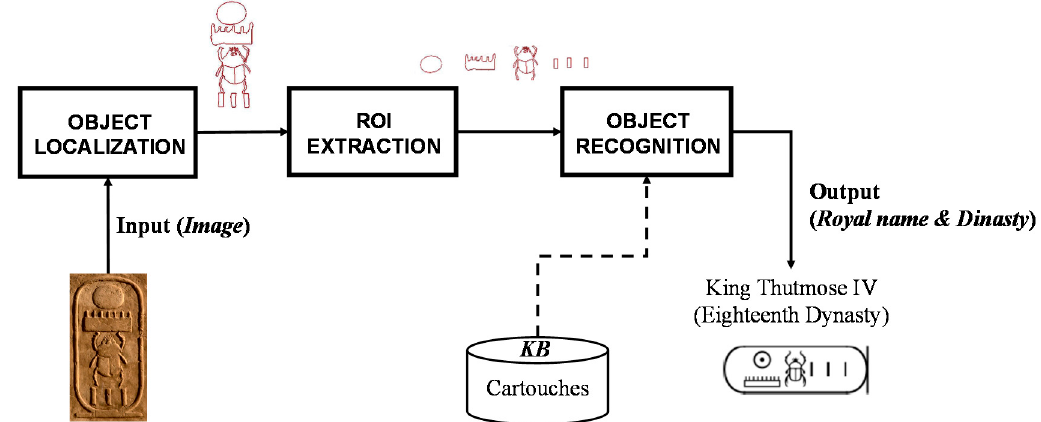
Figure 3. The proposed approach consists of three stages.